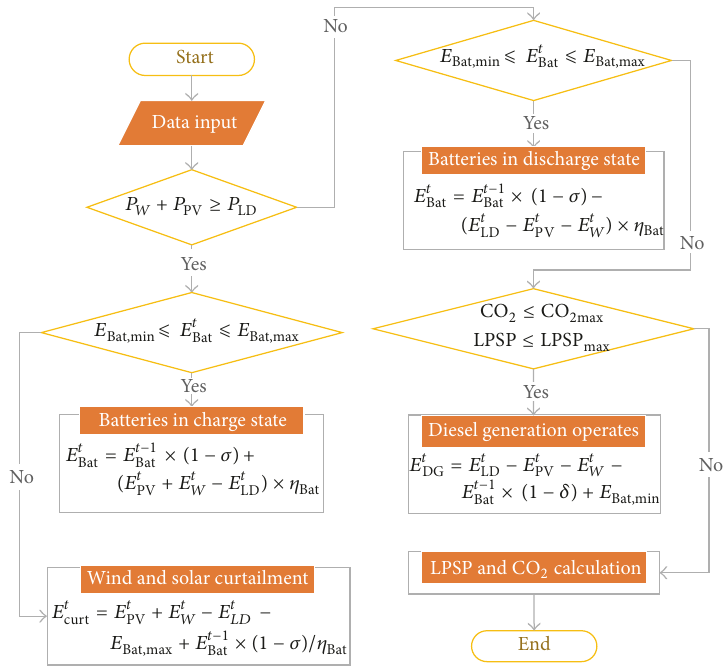
Figure 2: Power balance strategy of HPS.